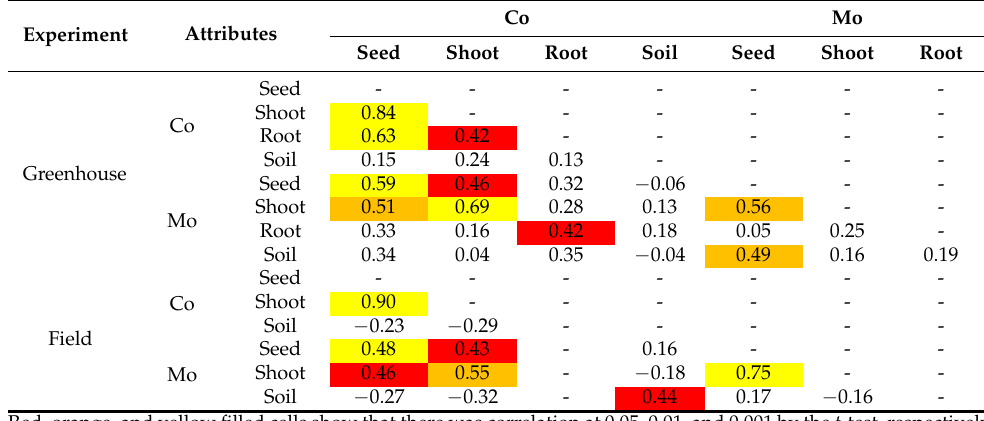
Table 5. Pearson’s correlation between Co and Mo concentrations in seeds, shoots, and roots of soybean under controlled and field